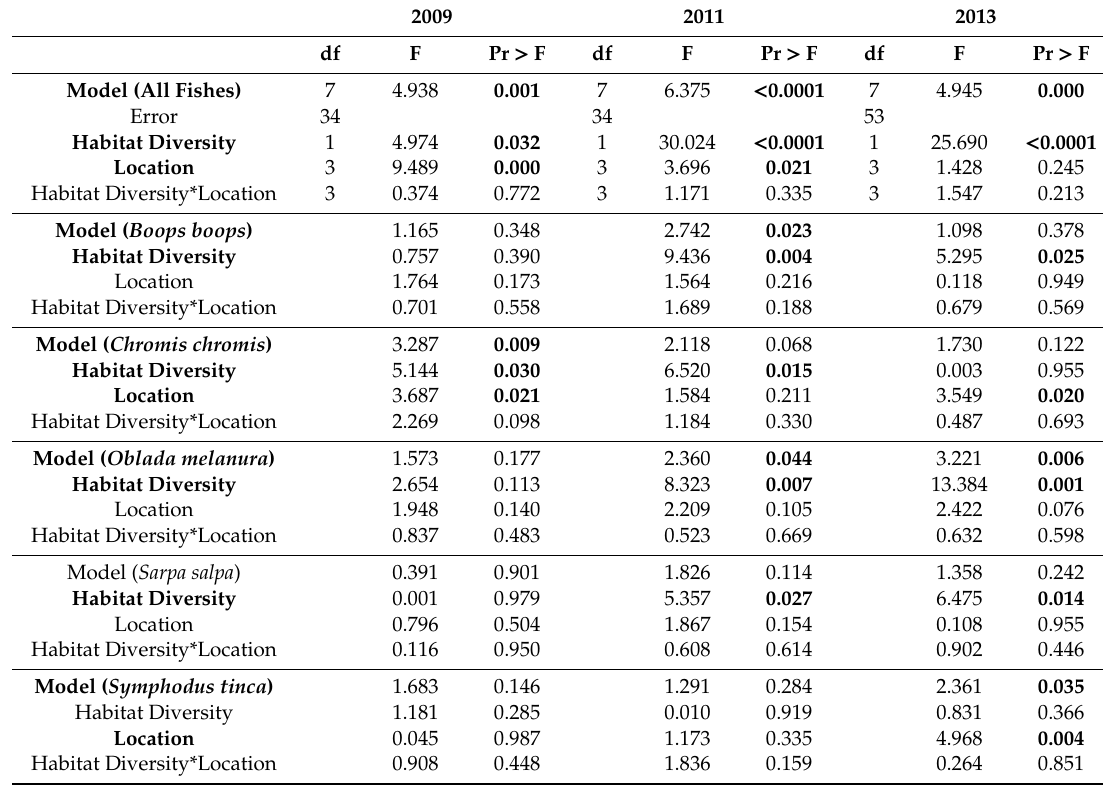
Table 3. Analysis of covariance (ANCOVA) results examining within-year variability related to Shannon–Wiener habitat diversity index and location (site) for density (fish m − 2 ) of all fishes and the five most abundant species. Significant values ( p < 0.05) and factors for which significance was observed in a given year are indicated in bold. Interactions (Habitat Diversity*Location) between factors that were significant in at least one given year are additionally included below. All other interactions were non-significant ( p >